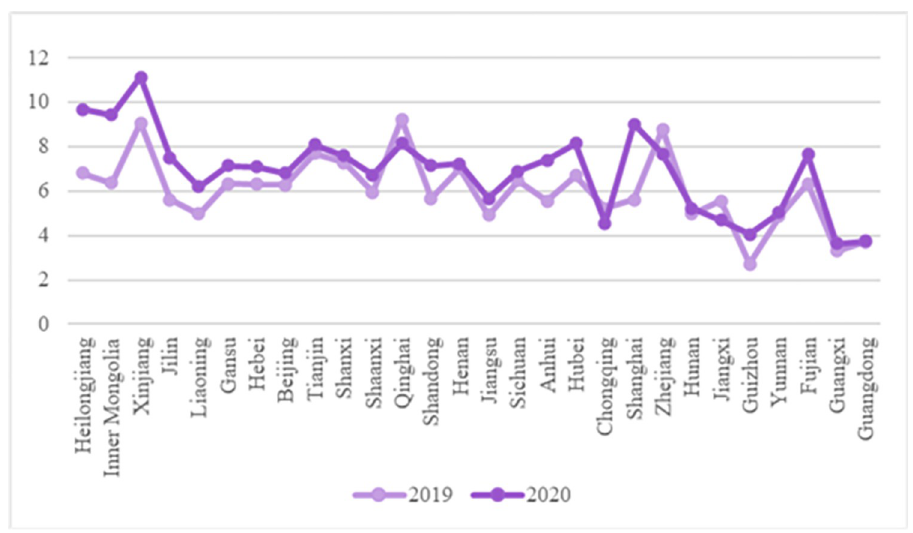
Fig 11. Broken line chart of eggplant price comparison across the